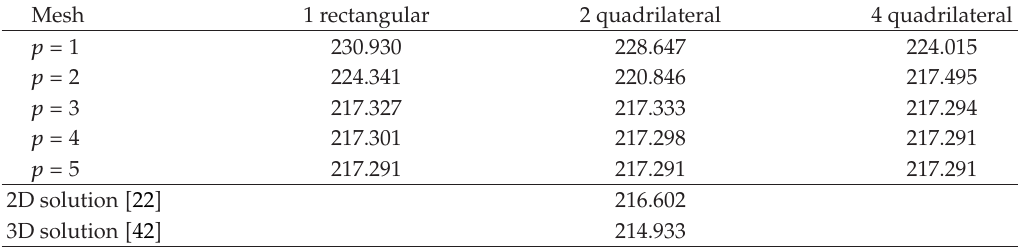
Table 2: Fundamental frequency parameter λ (cid:3)(cid:8) ωa 2 ρ 1 / 2 / 2000 πh (cid:6) of a simply supported sandwich